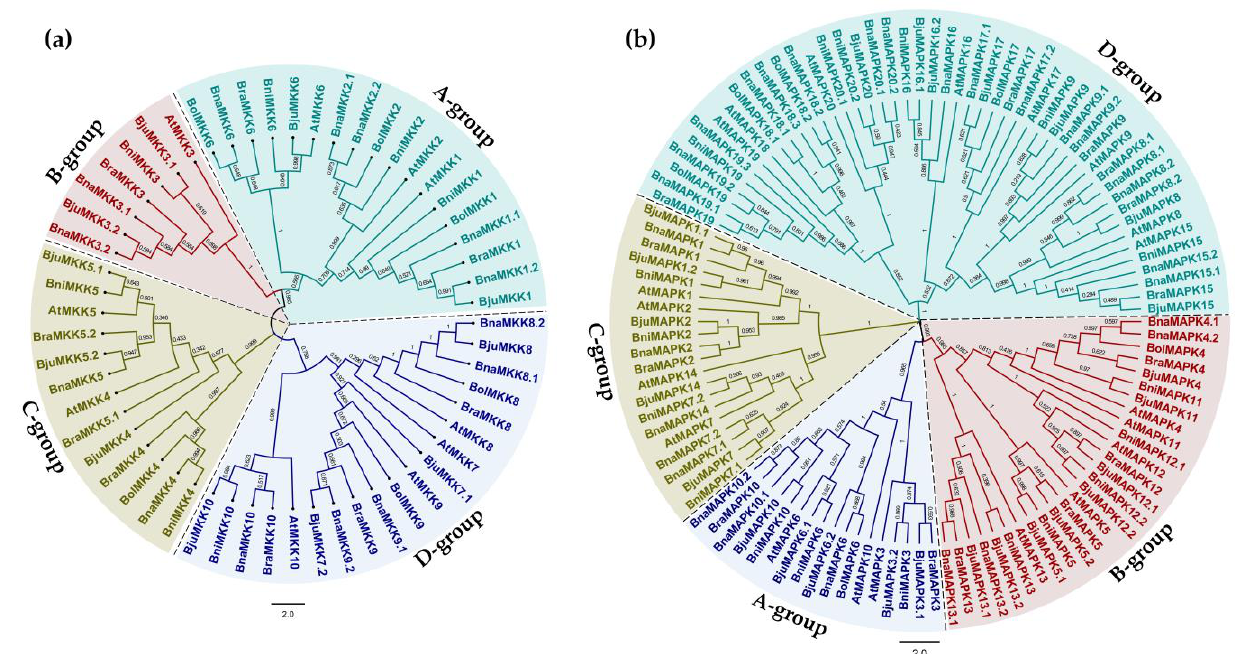
Figure 1. Phylogenetic analysis of MKKs and MAPKs family members from Arabidopsis thaliana ( At ), Brassica juncea ( Bju ), Brassica napus ( Bna ), Brassica nigra ( Bni ), Brassica oleracea ( Bol ), and Brassica rapa ( Bra ). ( a ) Phylogenetic trees of MKKs from Arabidopsis and five Brassica species. ( b ) Phylogenetic trees of MAPKs from Arabidopsis and five Brassica species. The unrooted phylogenetic trees were constructed using MEGA-X with the NJ method; the bootstrap test was performed with 1000 iterations. Different colored backgrounds indicate different groups.